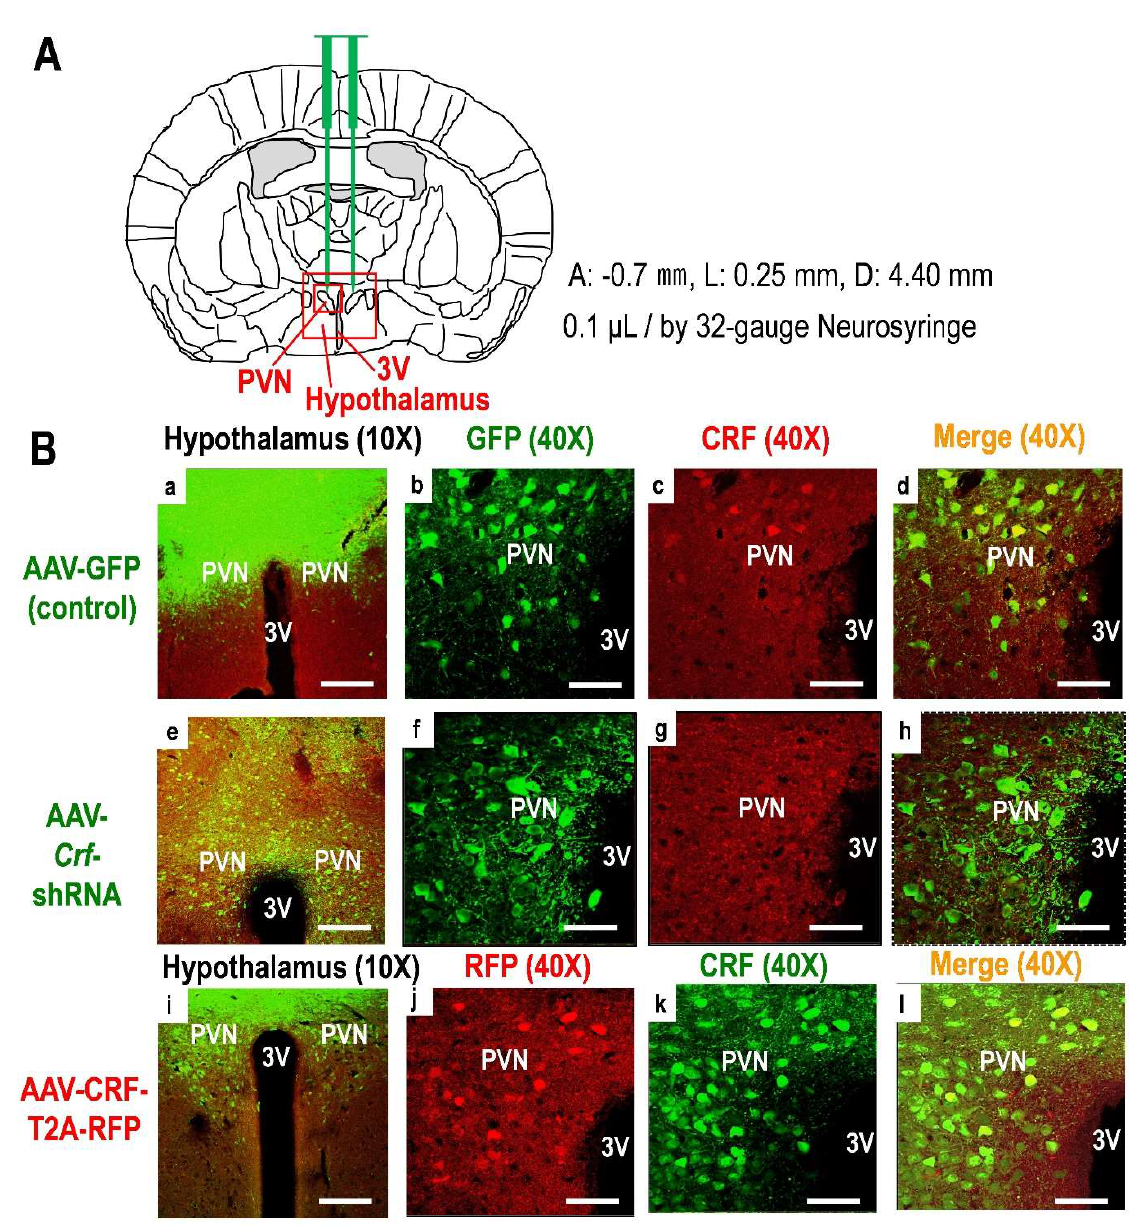
Figure 3. ( A ) AAV-PHP.eB virus injection maps according to the Paxinos mouse brain atlas (anterior: − 0.7 mm, lateral: 0.25 mm, depth: 4.40 mm). Green bars around the center of the brain map indicate virus injection needles and the location of virus injections into the hypothalamus, including the PVN (0.1 µ L of virus injected by 32-gauge neurosyringe). In the images, “3V” represents the third ventricle and “PVN” represents the paraventricular nucleus of hypothalamus in the red square, in the hypothalamus. ( B ) Transduction of mouse hypothalamus with AAV-PHP.eB vector expressing GFP or RFP and detection of mouse CRF by immunofluorescence in control (( a – d ); upper lane), knockdown (( e – h ); middle lane; Hy- Crf -KD), and overexpression (( i – l ); lower lane, Hy-CRF-OE) mice. In the images, “3V” represents the third ventricle and “PVN” represents the paraventricular nucleus of the hypothalamus. Scale bar = 200 µ m ( × 10 magnification) for ( a , e , i ) and 50 µ m for ( b – d , f – h , j – l ) ( × 40 magnification).